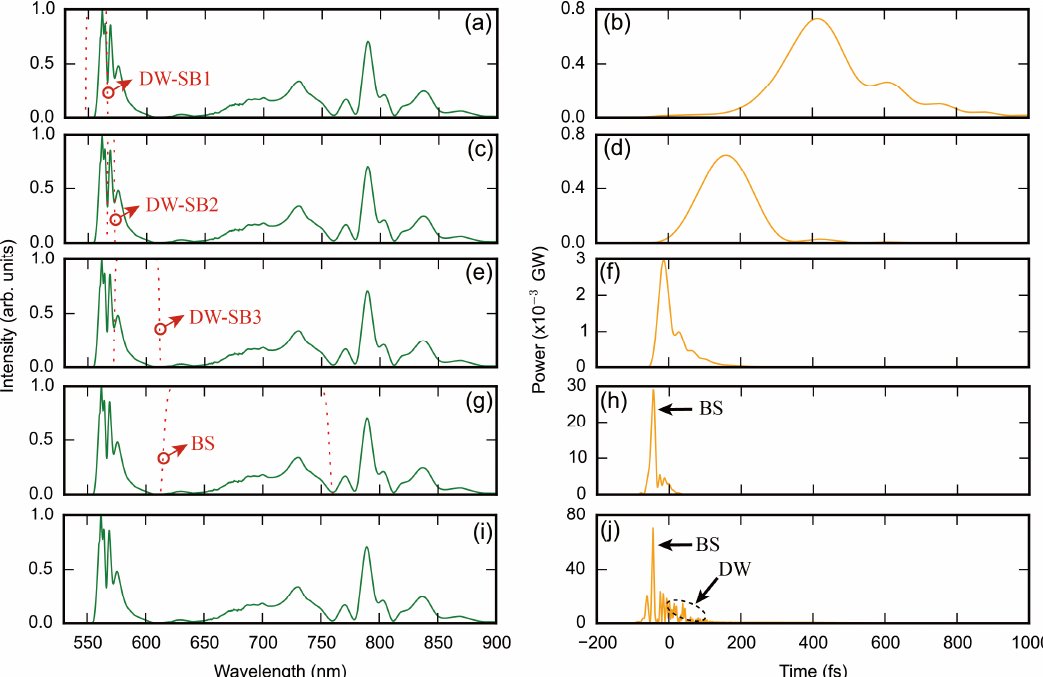
Figure 5. Plotted using the open source software Python(x,y). The green solid lines represent the simulated spectrum output of a 25-cm-long SR HC-PCF at an input energy of 2.6 µJ. In ( b , d , f , h ), the orange solid lines indicate the temporal profiles of the pulses through Fourier transforming the spectral bands (marked as red dashed lines) filtered by super-Gauss windows, and in ( j ), the temporal profile of the pulse obtained by Fourier transforming the entire output spectrum ( i ). In ( a , c , e ), DW-SB = dispersive wave spectral band and in ( g ), BS = blueshifting soliton.